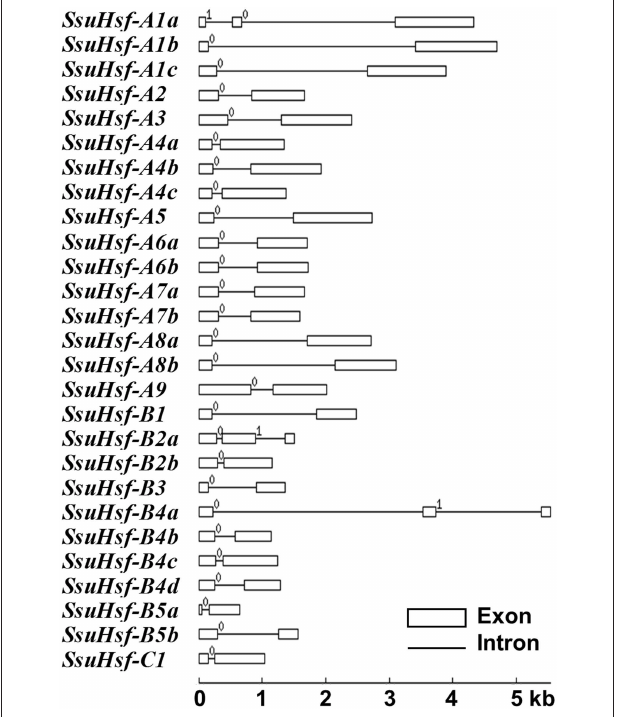
FIGURE 2 | Gene structures of SsuHsf genes. Boxes represent exons and lines represent introns. The numbers indicate the splicing phases of the SsuHsfs : 0, phase 0; 1, phase 1; and 2, phase